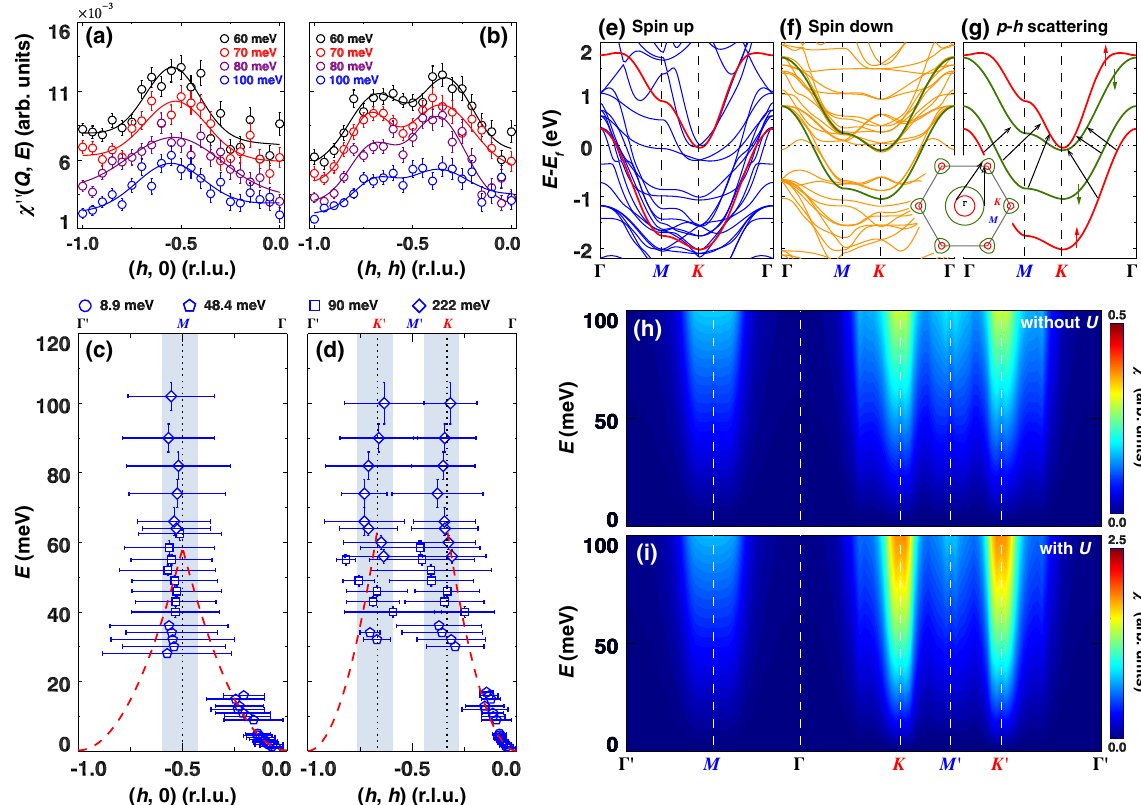
¼ 222 meV. For each scan, FIG. 3. (a),(b) Constant- E scans at various energies along [1, 0] and [1, 1] directions, respectively, with E i the energy intervals at selected energies were chosen to be (cid:2) 5 meV, and l was integrated over − 10 ≤ l ≤ 10 r.l.u. Solid lines are fits with Gaussian functions. Error bars represent one standard deviation throughout the paper. (c),(d) Spin dispersions along [1, 0] and [1, 1] directions, respectively. The peak centers were extracted from fittings to the constant- E scans as shown in (a) and (b). The horizontal error bars represent the FWHM of the constant- E scans with Gaussian fitting, and the vertical error bars represent the energy integration interval. Dashed lines are quadratic fits to the data below 20 meV. Dotted lines indicate the Brillouin zone boundaries. Shaded regions are guides to the eye. (e),(f) DFT calculations of spin-up and spin-down bands in the ferromagnetic state, respectively. (g) Schematic diagram for the particle-hole ( p - h ) scattering processes. The red and green bands with up and down spins, respectively, are simulated bands via tight-binding model on a triangular lattice. These bands are plotted over (e) and (f) for comparisons. Black arrows represent the p - h scattering occurring between bands with different spin directions. The inset shows the corresponding Fermi surface and the wave vectors corresponding to the most significant scattering near the Fermi level. Calculated bare (h) and RPA renormalized (i) spin excitation spectra below 100 meV induced by the p - h scattering processes in